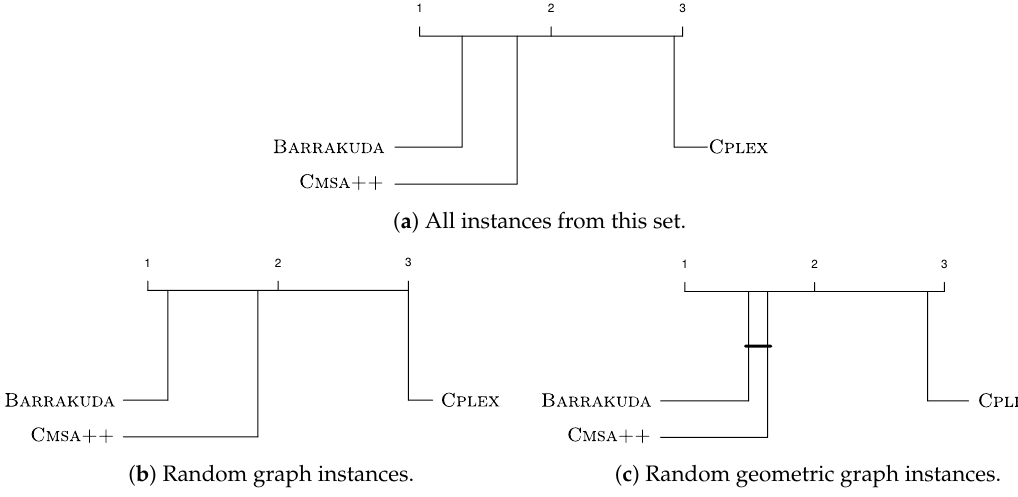
Figure 5. Critical difference plots concerning the challenging large problem